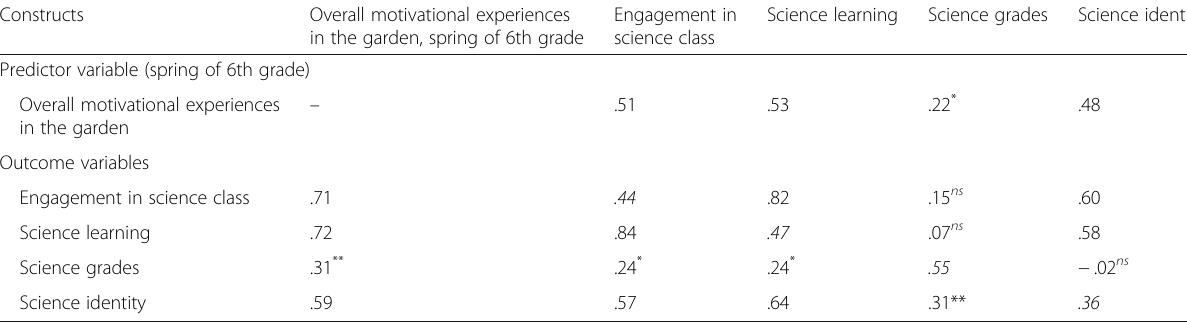
Table 2 Inter-correlations within time points and cross-time stabilities for study constructs